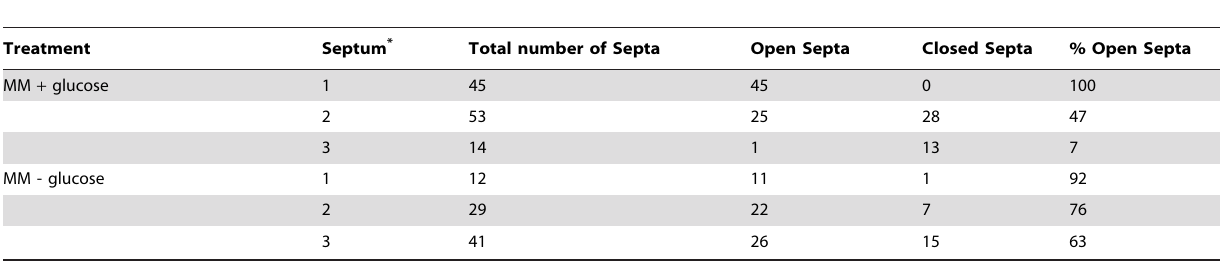
* Septum 1 separates the apical compartment from the second compartment; septum 2 separates compartment 2 and 3, and septum 3 compartment 3 and 4.